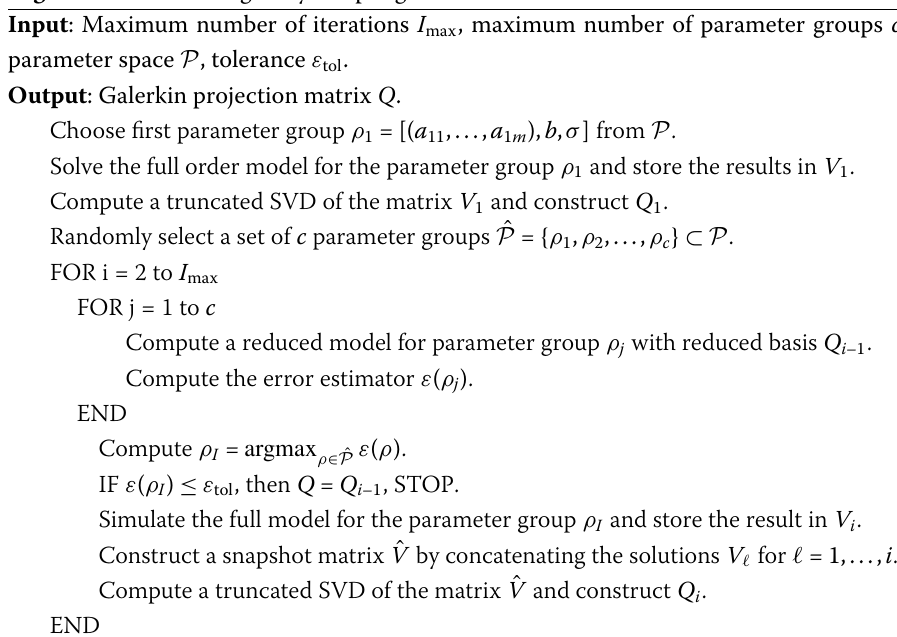
Algorithm 2 Classical greedy